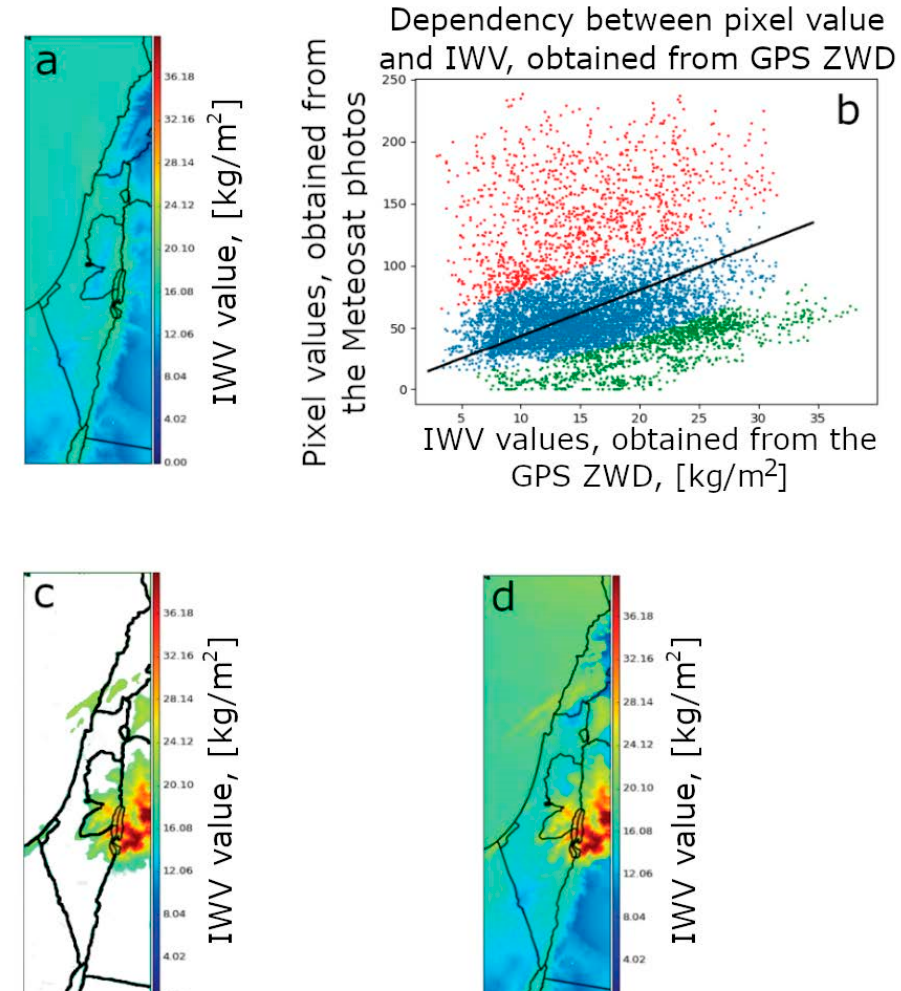
Figure 2. ( a ) GPS-IWV distribution map using Kriging interpolation. ( b ) Extracting the mathemati- cal dependency between METEOSAT 7.3 µm water vapor (WV) pixel value and integrated water vapor (IWV), obtained from GPS ZWD. The different colors for points correspond to 3 main re- gions, which depend on the station location, weather conditions (mainly cloudy), and satellite position. ( c ) Using the surface temperature differences between the Israel Meteorological Service (IMS) ground station measurements and METEOSAT-11 10.8 µm infra-red (IR) channel to identify spatio-temporal cloud distribution structures [32]. ( d ) The identified cloud features are mapped into the GPS-IWV distribution map when performing the interpolation between adjusted GPS station inside the